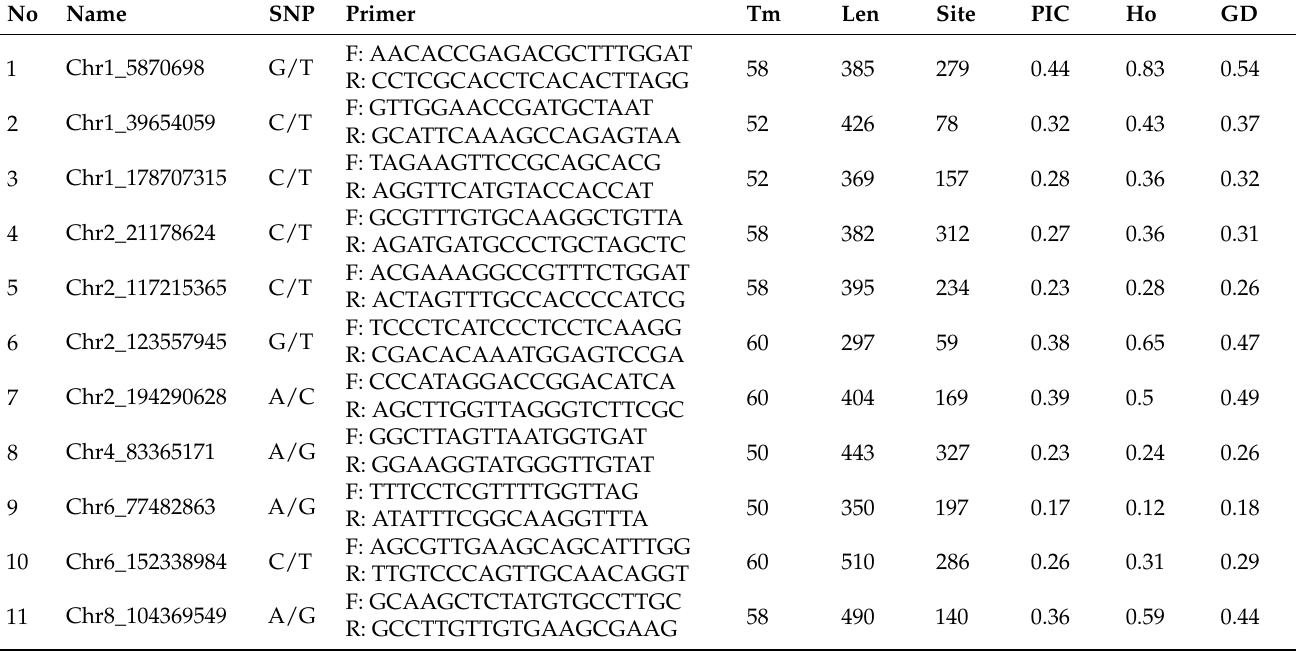
Table 3. 21 Primer information for 349